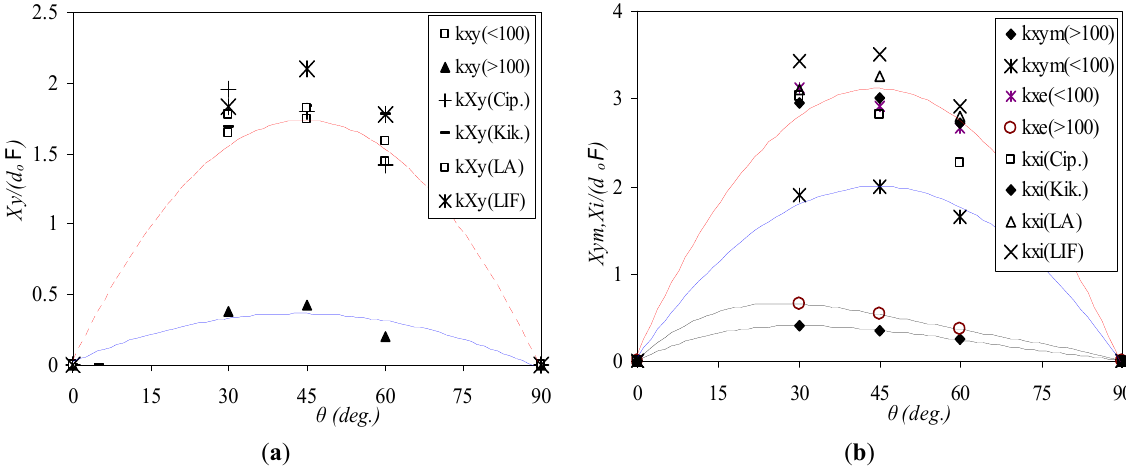
Figure 10. Slope coefficient for horizontal distance to ( a ) maximum jet centerline level ( kx F ) ); and ( b ) maximum jet edge level ( kx = X /(d y y 0 angle for densimetric Froude number below and above 100, together with results from previous